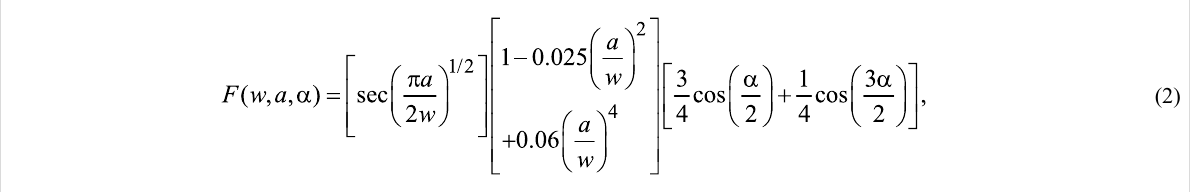
(2)of Figure 5: The stress–strain curves along armchair direction of MoS 2 sheet under three crack tip types: condition A; condition B; condition